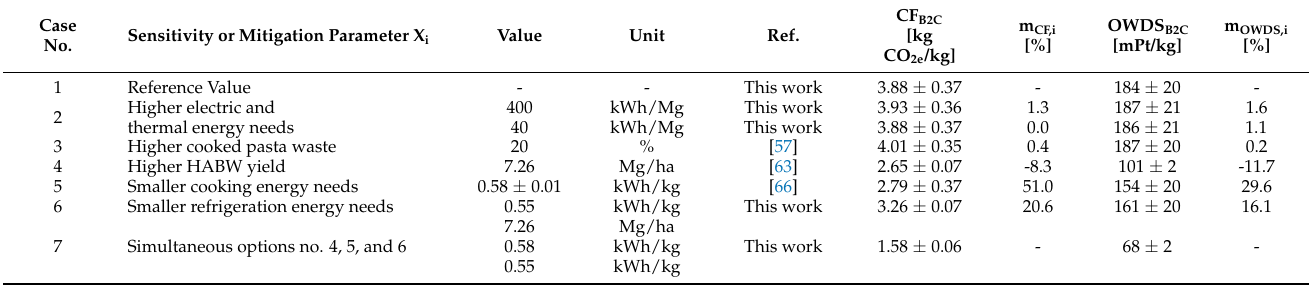
Table 9. Effect of the sensitivity analysis and some mitigation actions on the B2C carbon footprint and overall weighted damage score of 1 kg of low-GI fresh pasta according to the PAS 2050 and ReCiPe 2016 standard methods and corresponding percentage variation ratio, m CF,i or m OWDS,i , towards different percentage variation of each sensitivity or mitigation parameter X i accounted